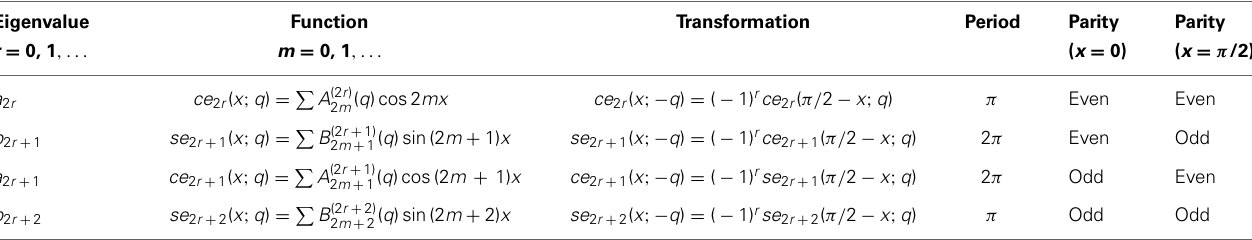
Table 1 | Mathieu cosine elliptic ( ce ) and sine elliptic ( se ) functions. Eigenvalue Function Transformation Period r = 0, 1